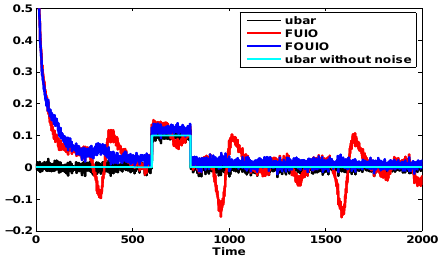
Figure 9. Unknown input and their estimations.